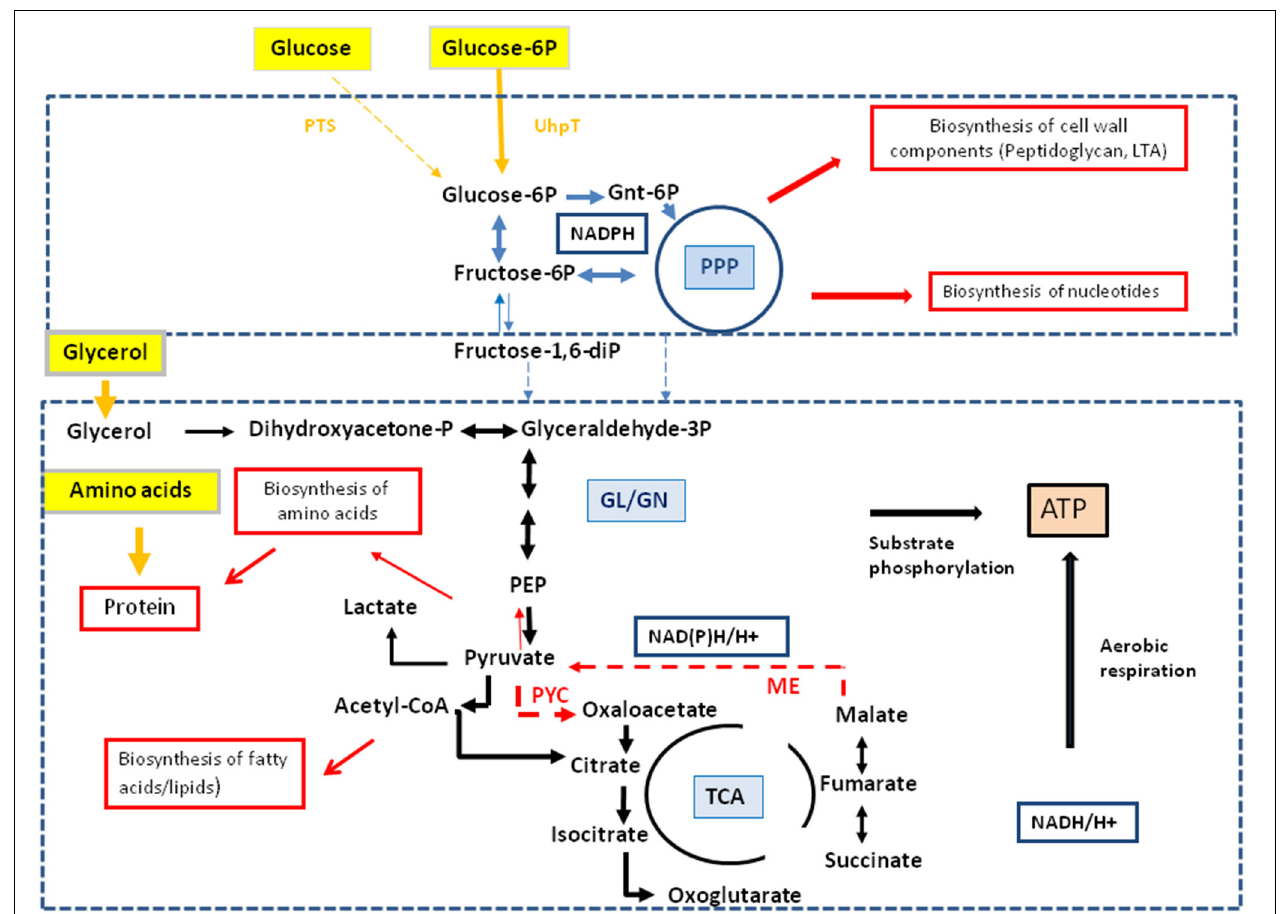
FIGURE 6 | Model for a bipartite metabolism for intracellular L. monocytogenes . Gray-framed yellow boxes and yellow arrows mark (by color intensity) the major carbon compounds taken up by the intracellular listeriae from the host cell. Catabolic reactions fed by glucose-6P and glycerol are indicated by blue and black arrows,